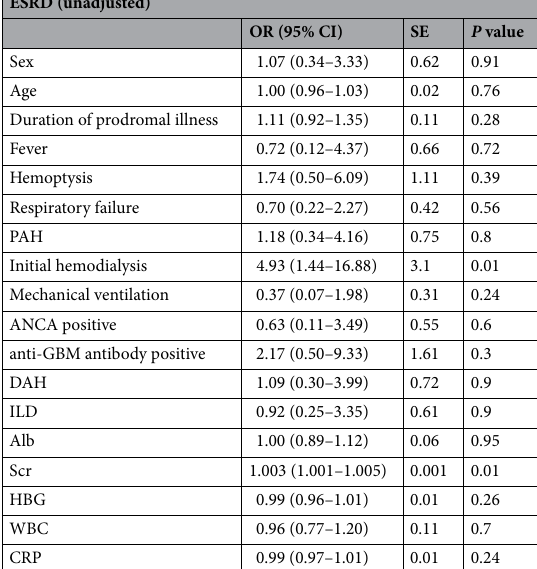
Table 3. Prognostic factors for ESRD in PRS patients.